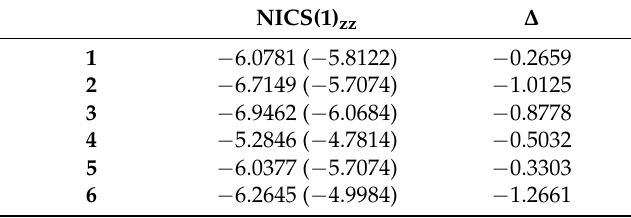
Table 4. NICS(1) zz in 6-OTX 3 -fulvene ··· NH 3 and 6-OTX 3 -fulvene (in parentheses), as well as their difference ( Δ ); all are in ppm.